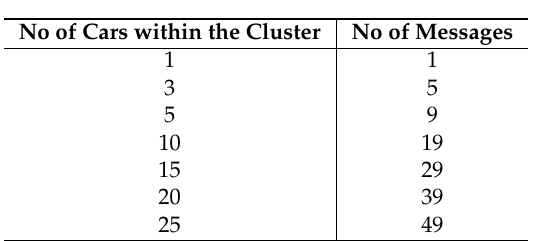
Table 3. Experimental results: Analysis of the number of messages within the cluster according to no of cars within the